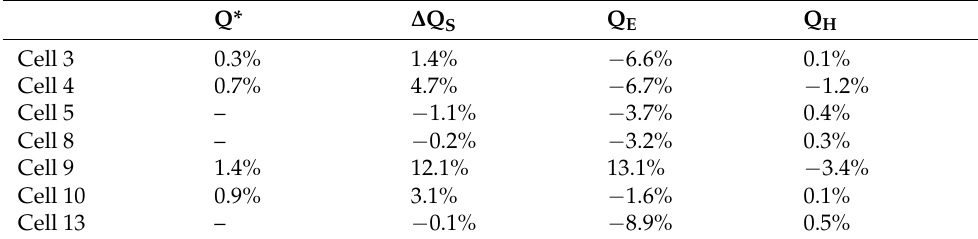
Table 7. Percentage changes in mean surface flux values per